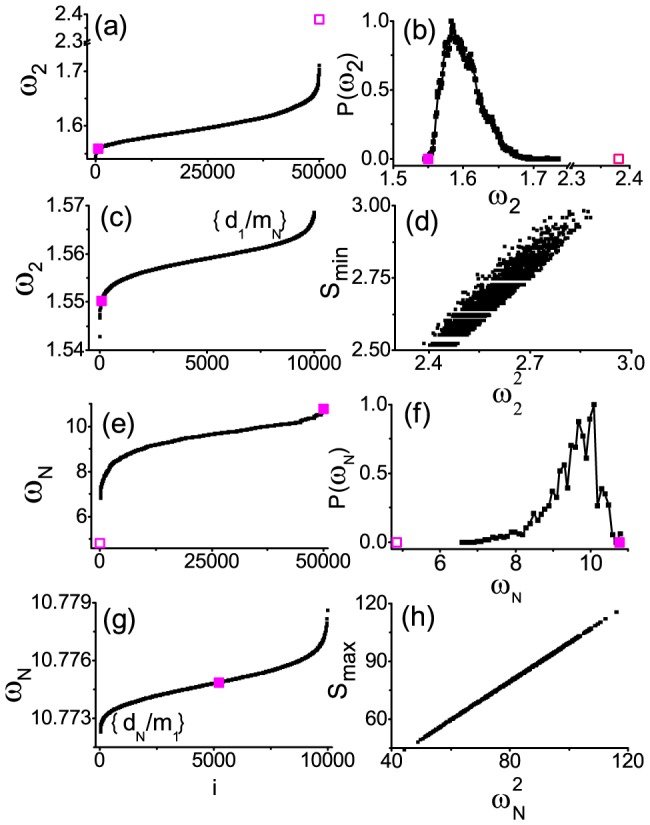
The results of  and  for a scale-free network.Similar to Figs. 1 and 2 for a scale-free network (N = 200, , , and ) instead.